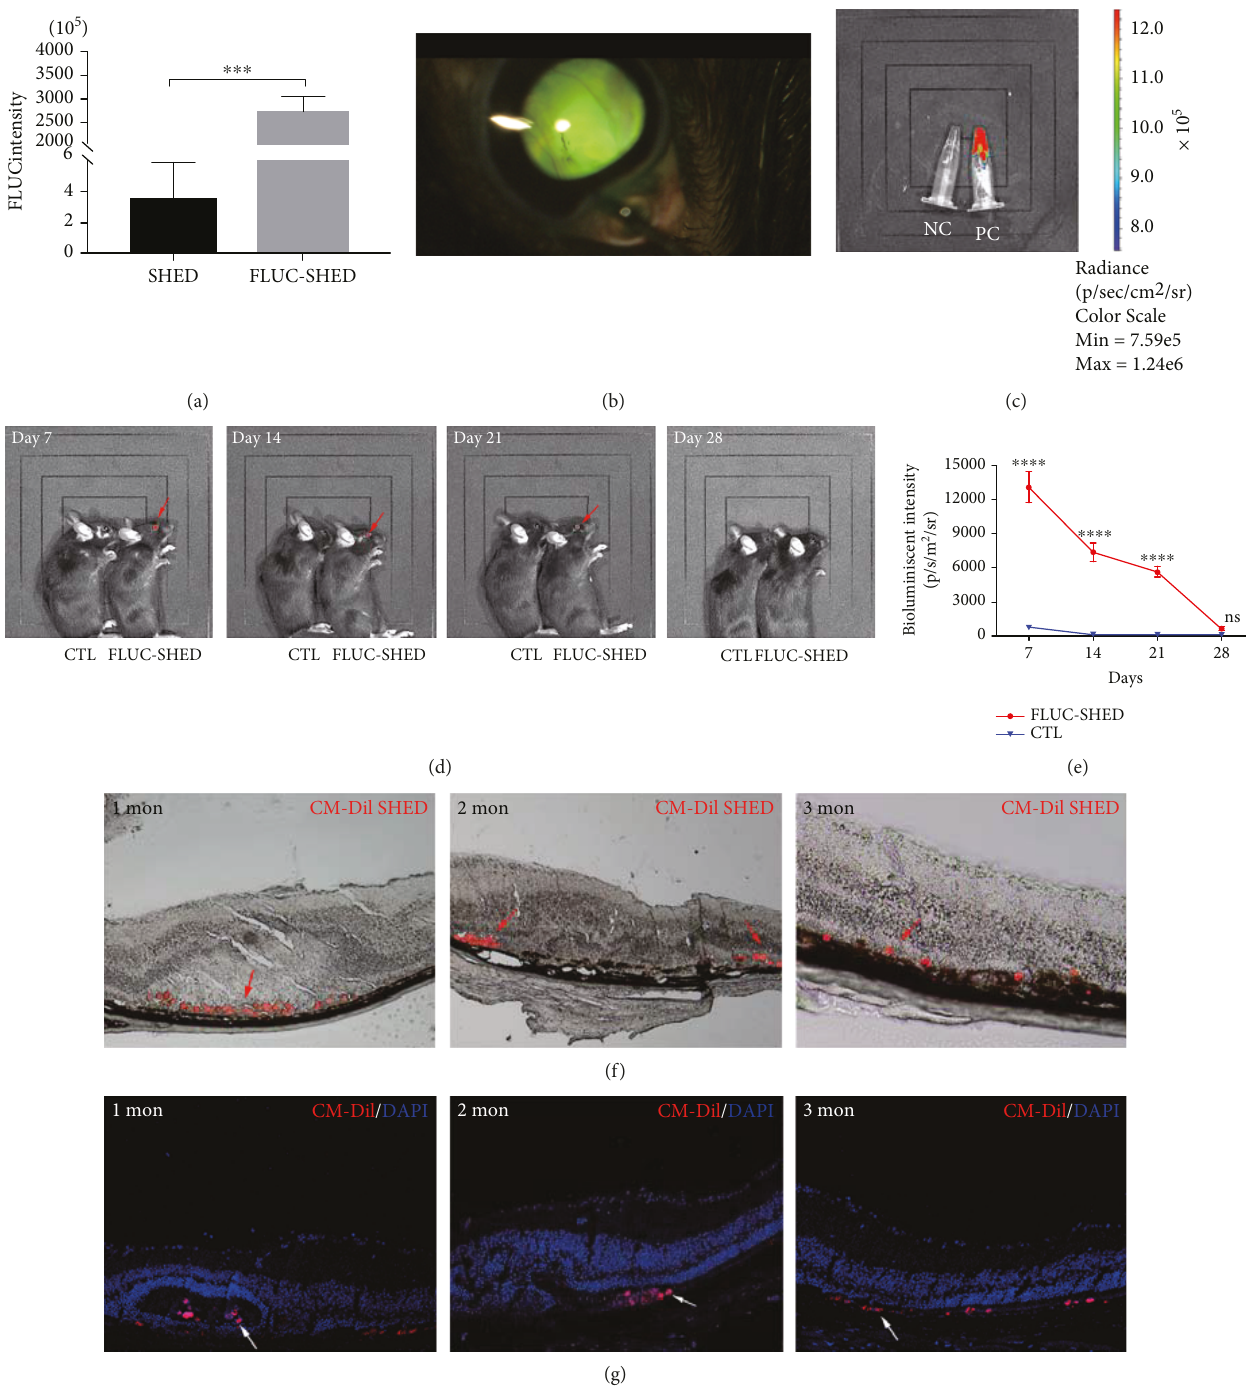
Figure 5: Sustainability and survival of SHEDs in vivo . (a) Relative fl uorescence intensity was signi fi cantly higher in luciferase-SHEDs than in untransfected SHEDs. (b) Photograph of the subretinal space with transplanted luciferase-SHEDs. (c) Bioluminescence imaging of Eppendorf tubes containing luciferase-SHEDs (positive control, PC) emitting a strong bioluminescent signal while negative control SHEDs (NC) displayed no signal. (d) In vivo bioluminescent imaging of mice at 7, 14, 21, and 28 days after transplantation. A signal was emitted from the eye area speci fi cally on day 7, 14, and 21 (red arrows). (e) Line chart showing the bioluminescent signal of the luciferase-SHEDs group declined rapidly with time, while the control group signal remained low ( ∗ p < 0 05 ; ∗∗∗∗ p < 0 0001 ). (f)-(g). Bright fi eld images (f) and fl uorescent images (g) displaying SHEDs stained red with CM-Dil (red arrows for (f) and white arrows for (g)) in the subretinal space 1, 2, and 3 months after transplantation. Scale bar: 50 μ m